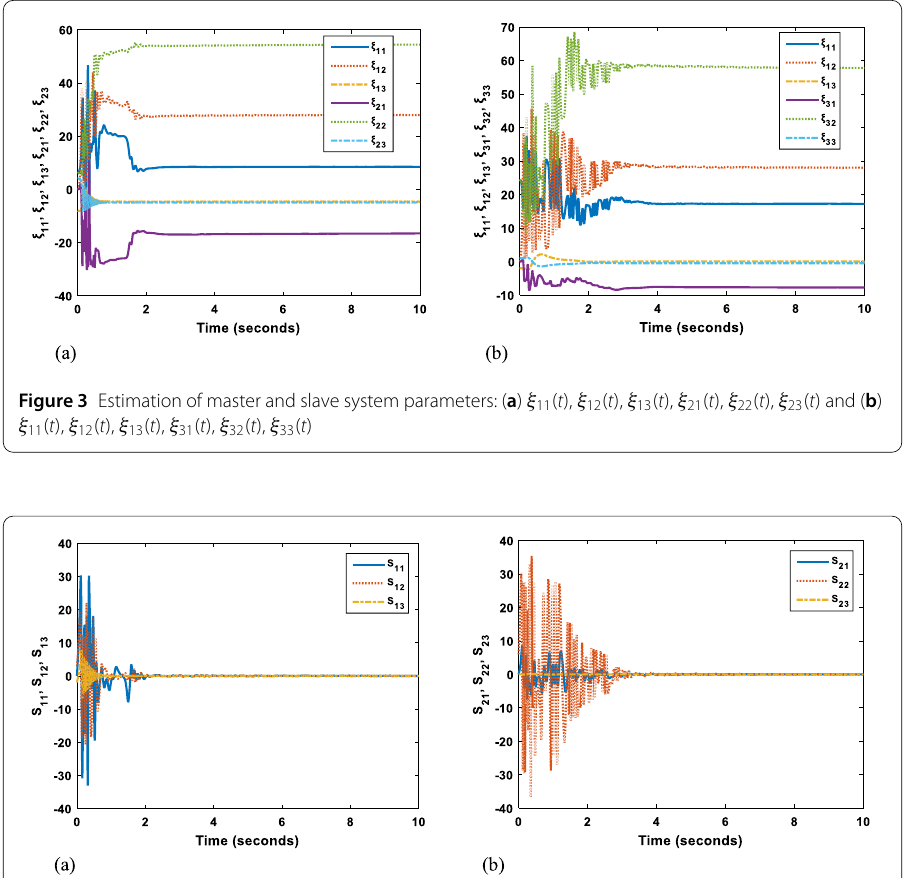
depicts the projective synchronization error of systems (54), (55), and (56) in the presence of suggested controller (16). It is represented that error via the suggested controller tends to zero, which shows that the projective synchronization is realized between fractional- order multiple chaotic systems with uncertain parameters and disturbances. Figure 3 dis- plays the estimate of the master and slave system parameters. The uncertain parameters of fractional-order multiple chaotic systems are identified correctly, and the adaptive pa- rameters move toward some true values. The trajectories of sliding surface (13) are shown in Fig.